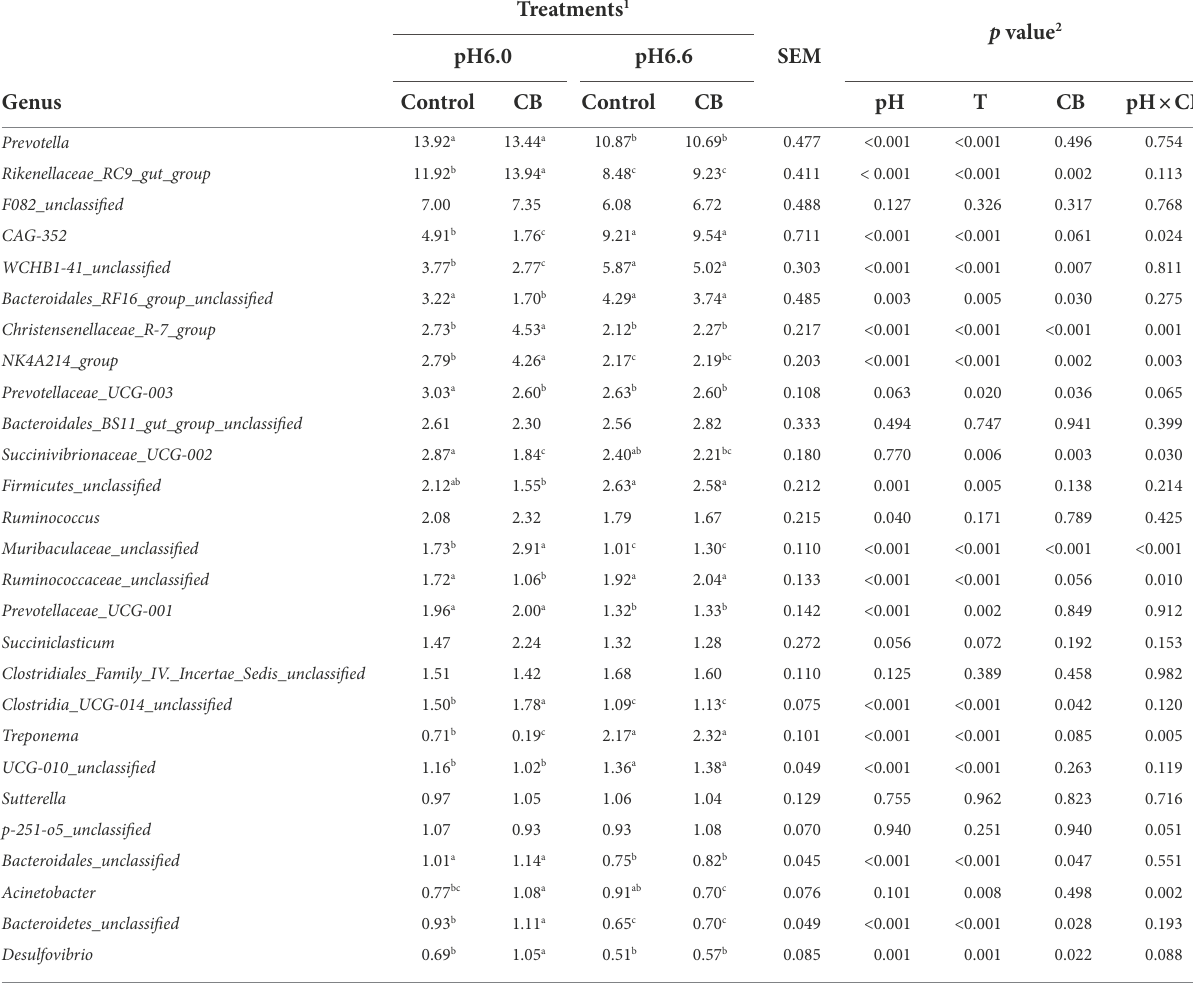
TABLE 5 The relative abundance (%) of bacterial genus (>1% at least in one group) in ruminal fermentation fluid supplemented with CB and without CB (control) at low or high media pH after 24 h of vitro